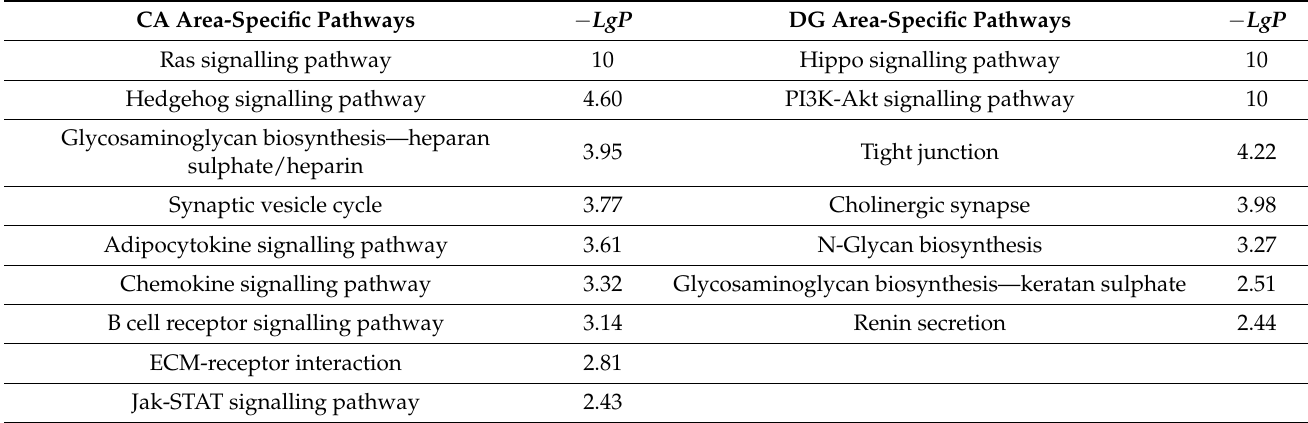
Table 5. Different pathways regulated by the changed miRNAs in CA and DG